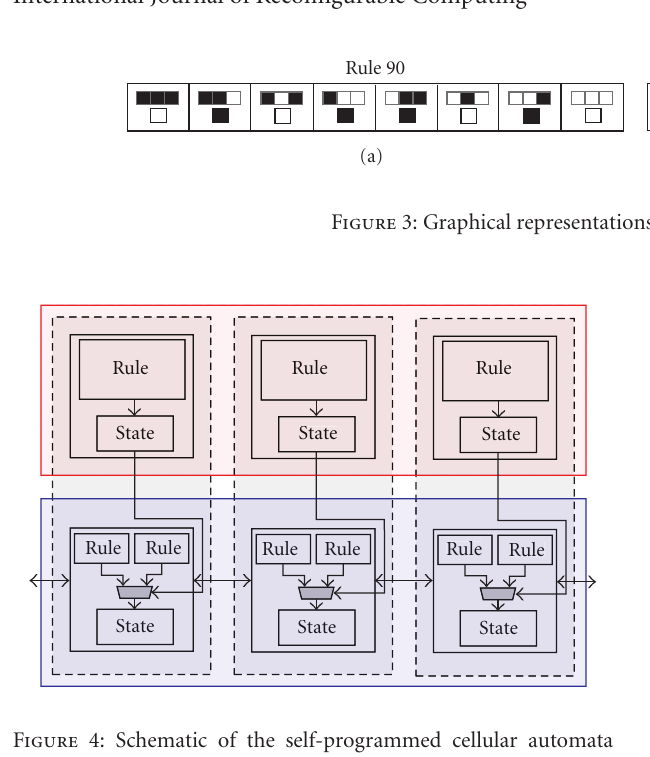
Figure 4: Schematic of the self-programmed cellular automata